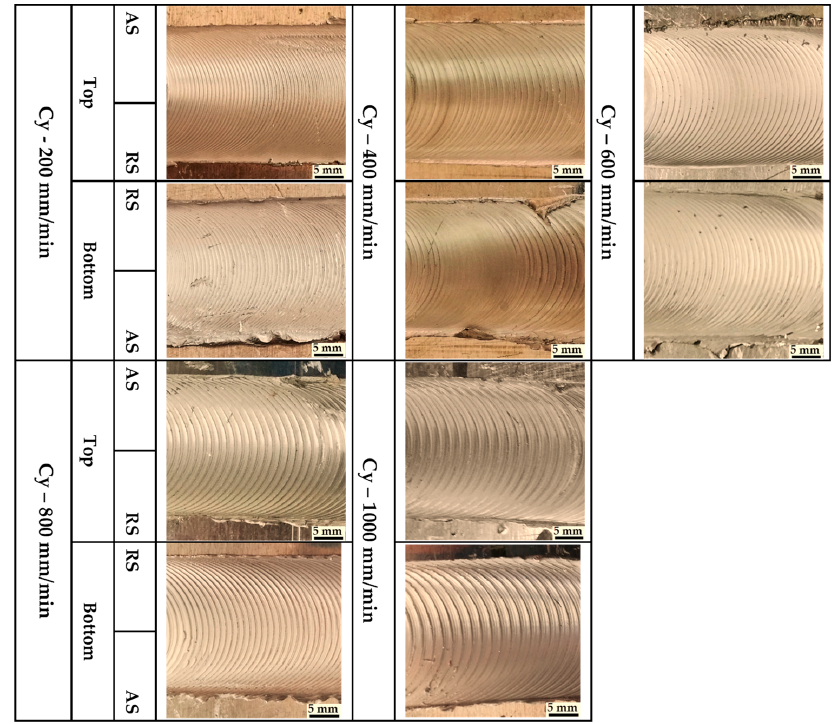
Figure 11. Top and bottom views of BT-FSW joints using Cy pin.